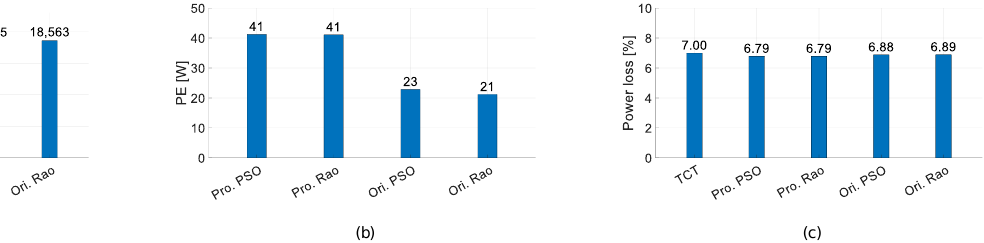
Figure 19. Comparison of performance metrics of PV array under the right edge of the